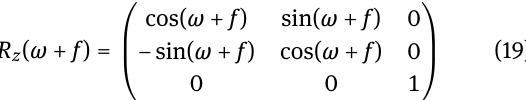
Figure 10. Geometric model on orbit coordinate system